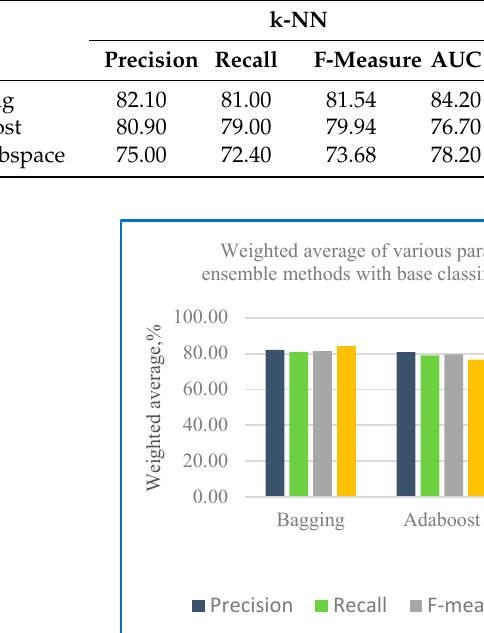
Table 10. Performance measures with base classifiers of k-NN and RF on holdout method.